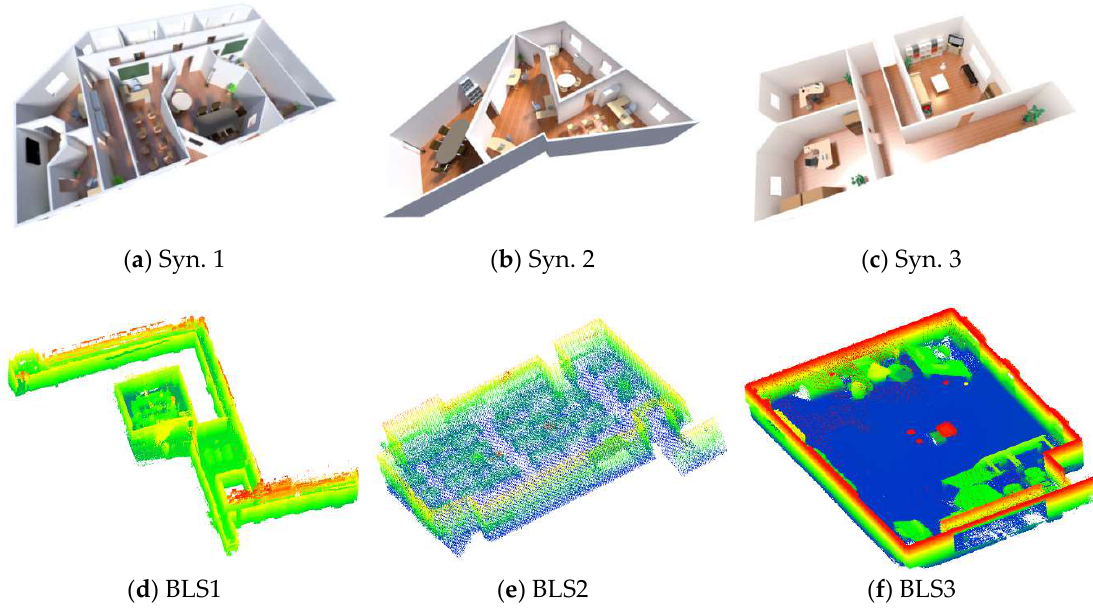
Figure 7. The datasets used for evaluating our approach: ( a – c ) Synthetic datasets [8], and ( d – f ) backpack laser scanner (BLS) datasets (colors indicate different height).